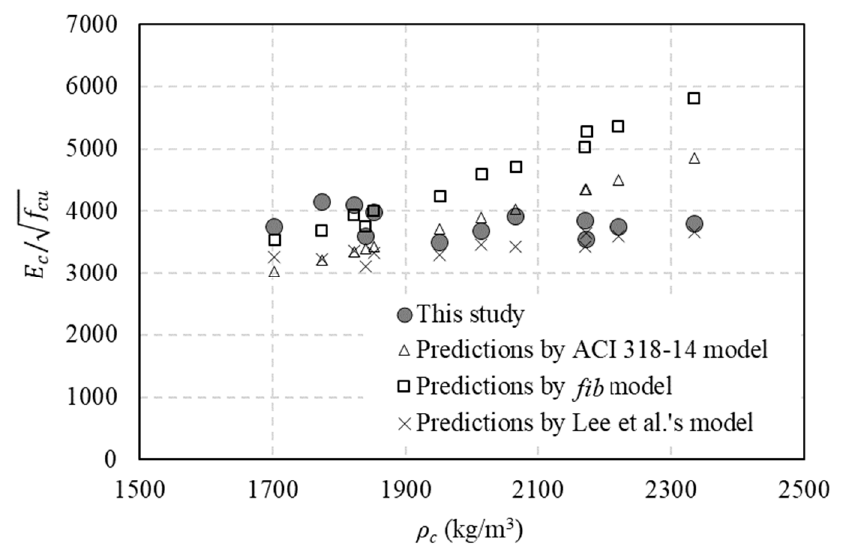
ff ect of ρ c on the elasticity Figure 6. Effect of ρ c on the elasticity modulus. Figure 6. E